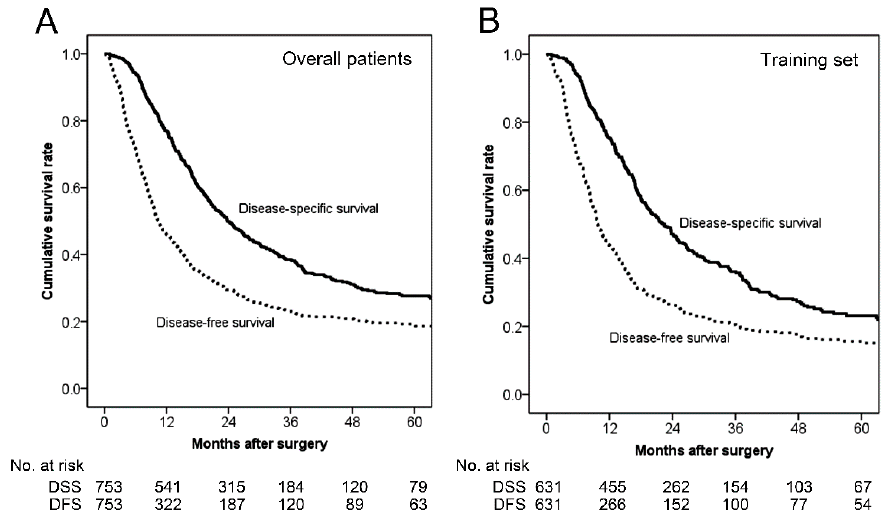
Figure 1. Kaplan-Meier survival curves of the overall patients and the training set. ( A ) In the overall patients ( n = 753), the median disease-specific survival (DSS) was 23.8 months, and the 1-, 2-, and 5-year DSS rates were 77.0%, 49.9%, and 27.7%, respectively. The median disease-free survival (DFS) was 10.4 months, and the 1-, 2-, and 5-year DFS rates were 46.0%, 29.5%, and 18.9%, respectively. ( B ) In the training set ( n = 631), the median DSS was 23.6 months, and the 1-, 2-, and 5-year DSS rates were 77.2%, 48.7%, and 26.0%, respectively. The median DFS was 10.4 months, and the 1-, 2-, and 5-year DFS rates were 45.6%, 28.6%, and 18.7%,